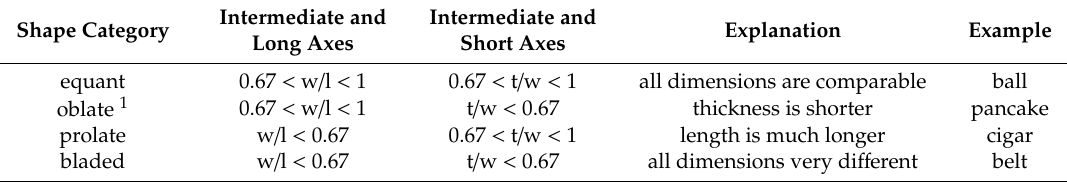
Table 1. Explanation of convex shape classes after [46]; l , w and t are length (maximum axis), width (intermediate axis) and thickness (minimum axis, perpendicular to bedding),